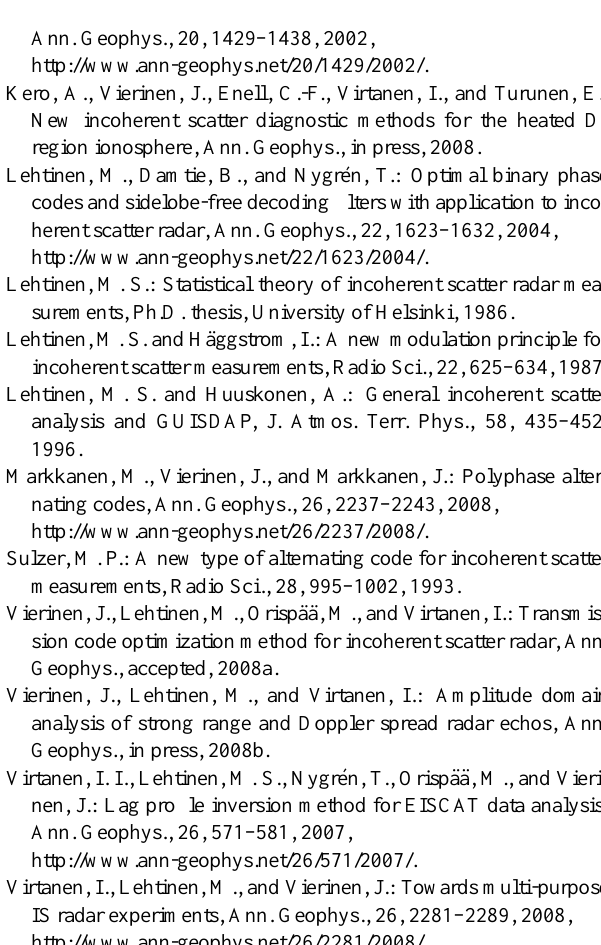
Fig. 10. A set of 150 randomly chosen pulses of 15 bauds each. This many pulses are necessary to make random code sets to be comparable to alternating code